Question: What caption would you write for this figure?
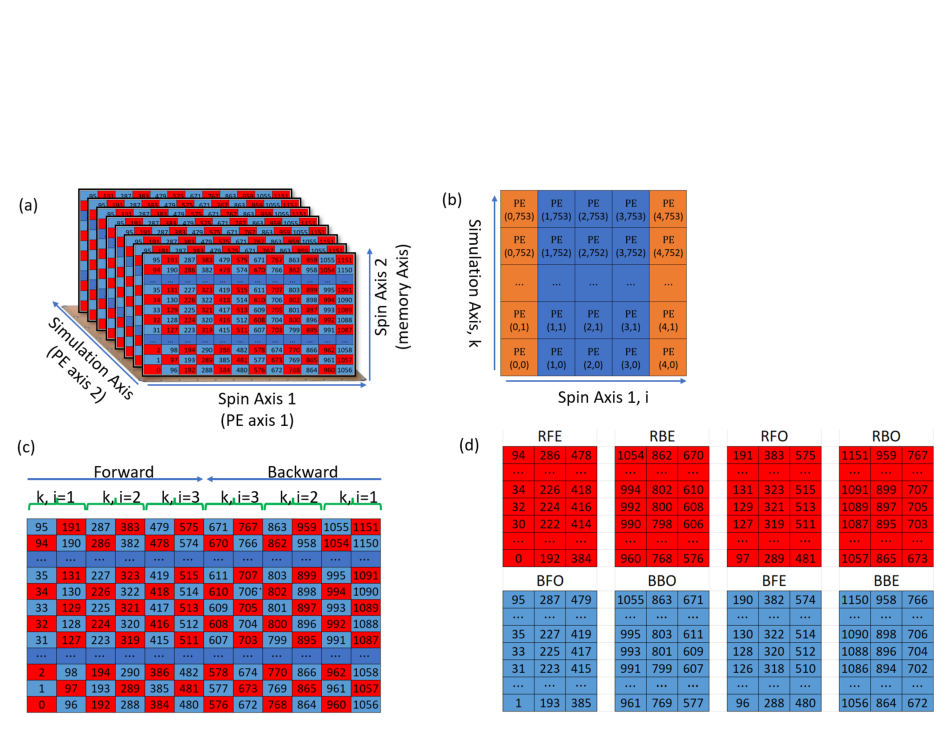
Answer: Conceptual layout of the 12 × 96 2D Ising model on WSE hardware. (a) The WSE is used to solve multiple instances of the 2D Ising model, where each instance is solved independently on a single column of the WSE. Note that the real WSE-2 architecture contains nearly 1 million PEs distributed over 756 columns. We devote one axis of PE’s to one of the axis of spins in the 2D Ising model, the second axis is devoted to simulations in parallel. The second spin axis is held in the memory of each PE. (b) The conceptual layout within the WFA with a single fold. Each simulation spans 5 PEs (3 workers, blue, and 2 moats, orange). The expanded and PBC updated column vectors are spread across the spin axis in order. The moats hold one axis of boundary condition data. The second axis of BC data is held in the top and bottom of each vector on the workers memory space. (c) Checkerboard decomposition. (d) 8-array representation on the WSE. For instance, the RFE array refers to spin belong to red